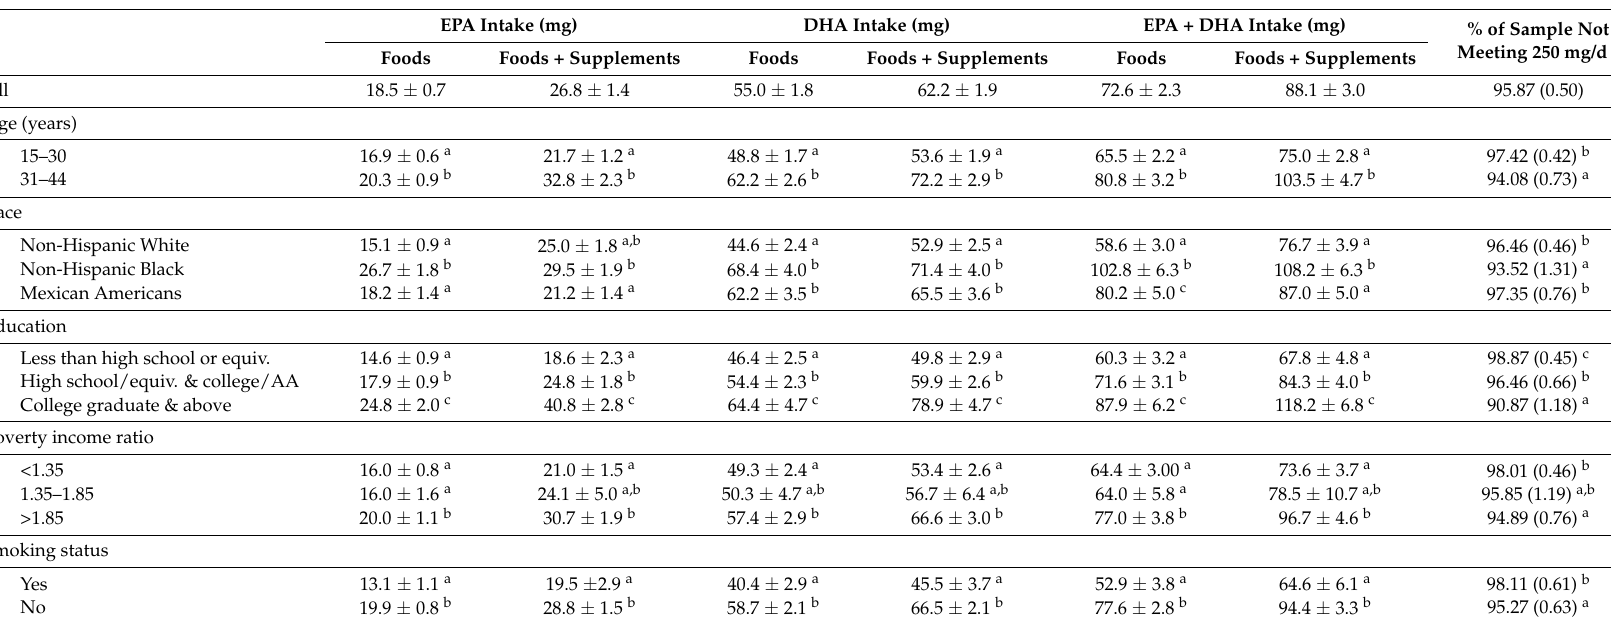
Table 5. Mean usual daily intake of EPA and DHA from foods alone, and from foods and dietary supplements among childbearing-age women for a fully qualified sample 2001–2014